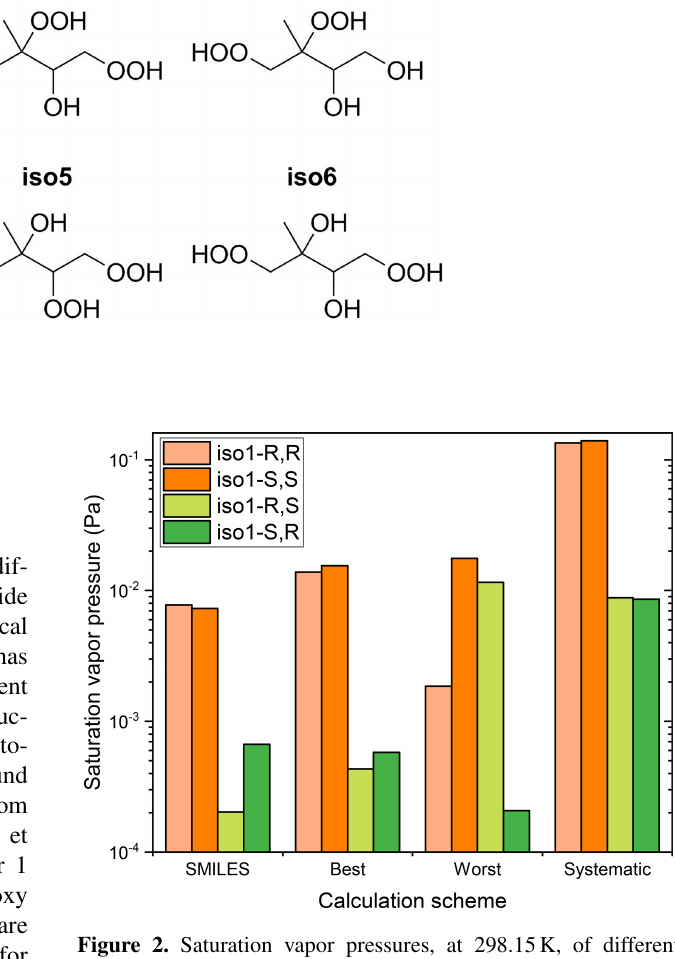
Figure 2. Saturation vapor pressures, at 298.15K, of different stereoisomers of structural isomer 1 of the dihydroxy dihydroper- oxide C 5 H 12 O 6 , at 298.15K, calculated using COSMOtherm ver- sion 18 and the BP_TZVPD_FINE_18 parameterization (based on BP/def2-TZVPD//BP/def-TZVP quantum chemical data), using different conformational sampling